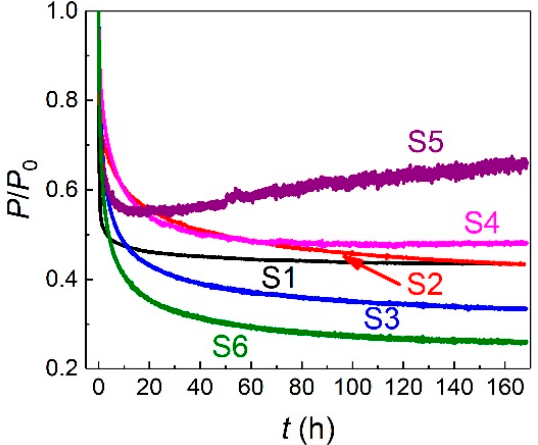
Figure 1. Power losses of S1–S6 during DC aging. Aging condition: Heated at 135 °C and applied an electric field of 0.9 E B for more than 160 h, where E B is the electric field when current density is 1 mAcm − 2 and is called breakdown field.